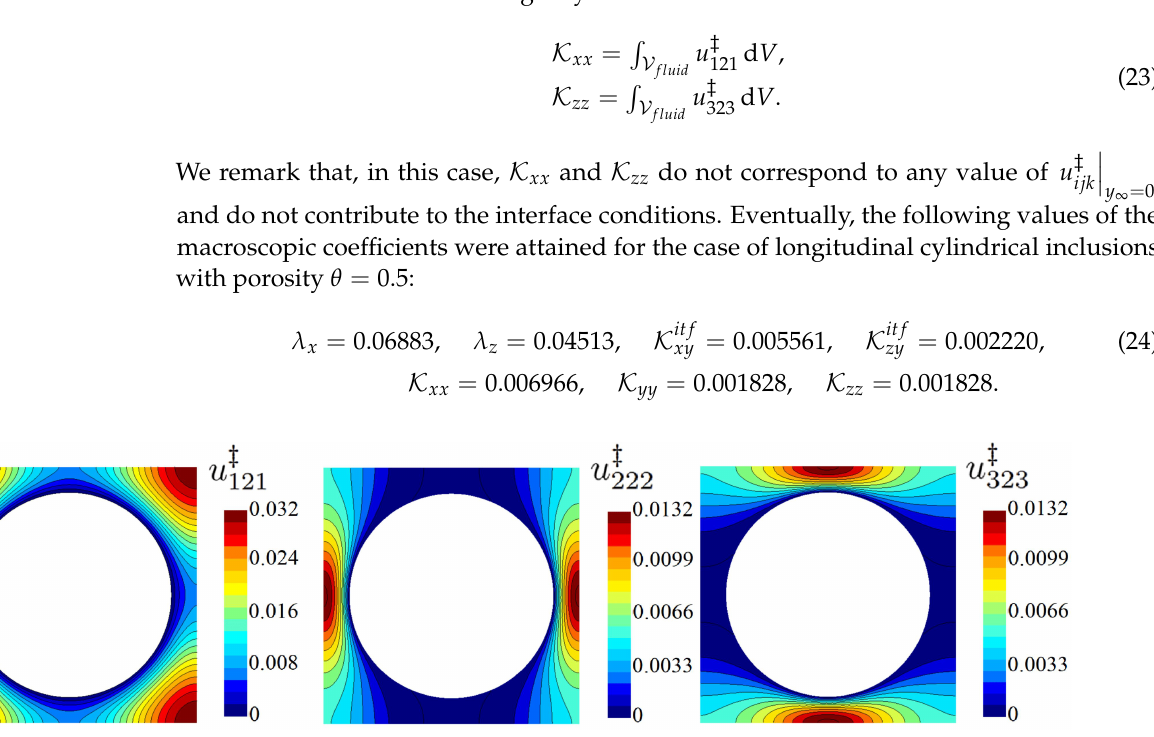
Figure 3. A fully periodic unit cell over which fields of u ‡